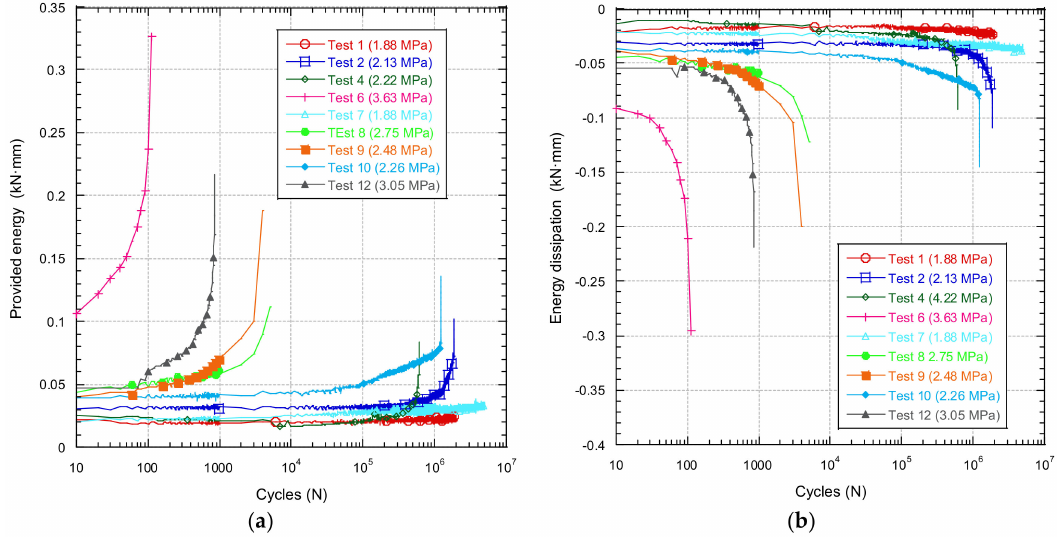
Figure 17. Evolution of the provided ( a ) and stored ( b ) energy during the fatigue